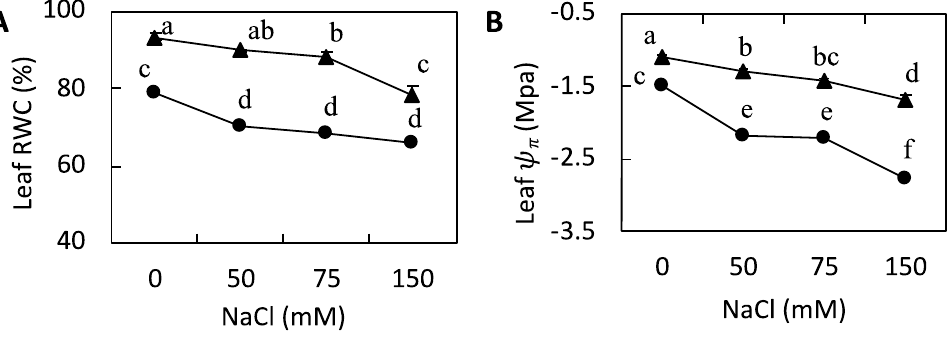
Figure 3. The effect of increasing salinity on the water balance in barley ( (cid:78) ) and Peucedanum japonicum ( • ) leaves. ( A ) Relative water content (RWC) and ( B ) osmotic potential. The values represent the means (±SE) of four replicates. Different letters in the figures indicate significant differences between the treatments of both plant species at P ≤ 0.05, as determined using a one-way ANOVA with the Duncan test (5% significance level). Table 1. The effect of increasing salinity on carotenoid, chlorophyll a , and chlorophyll b concentrations (mg g −1 fresh weight) in barley and Peucedanum japonicum (PJT).